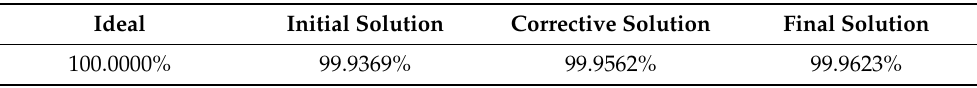
Table 27. Production time percentage for every component yielded from training the model with standalone uncoated roller for the bleaching machine